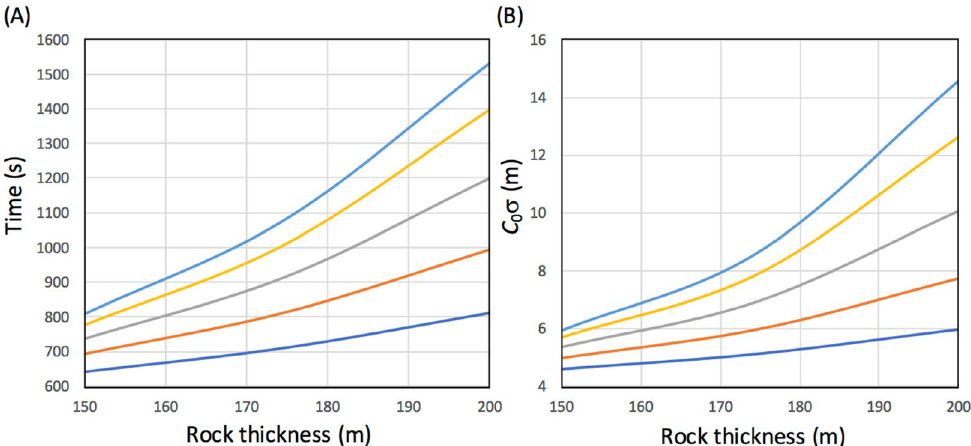
Figure 8. Time required for recording one muon track as a function of rock thickness for various muon arrival angles from horizon (from top to bottom—sky blue: 500 mrad; yellow: 450 mrad; gray: 400 mrad; red: 350 mrad; and blue: 300 mrad) ( A ) and the corresponding c 0 σ ( B